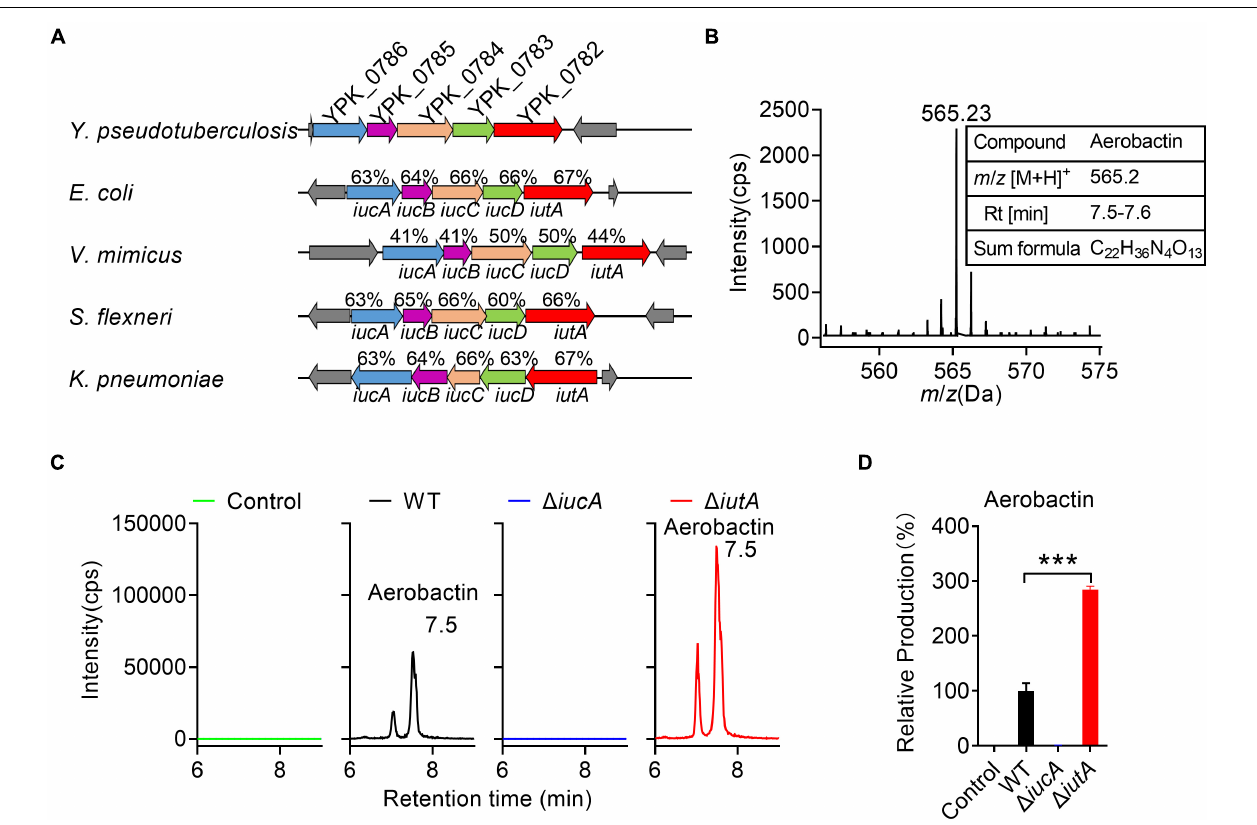
FIGURE 1 | Aerobactin production from the iucABCD - iutA operon in Yersinia pseudotuberculosis . (A) Comparison of IucABCD-IutA amino acid sequences from different species. The accession numbers of SwissProt accession numbers of proteins from different species: Y. pseudotuberculosis YPIII (gi:169749569, 169749568, 169749567, 169749566, 169749565); Escherichia coli O45:K1:H7 S88 (gi:7119436, 7119437, 7119438, 7119439, 7119366); Vibrio mimicus (gi:991835833, 991835832, 991835831, 991835830, 991835829); Shigella flexneri 2457T (gi:30043313, 30043312, 30043311, 30043310, 30043309);